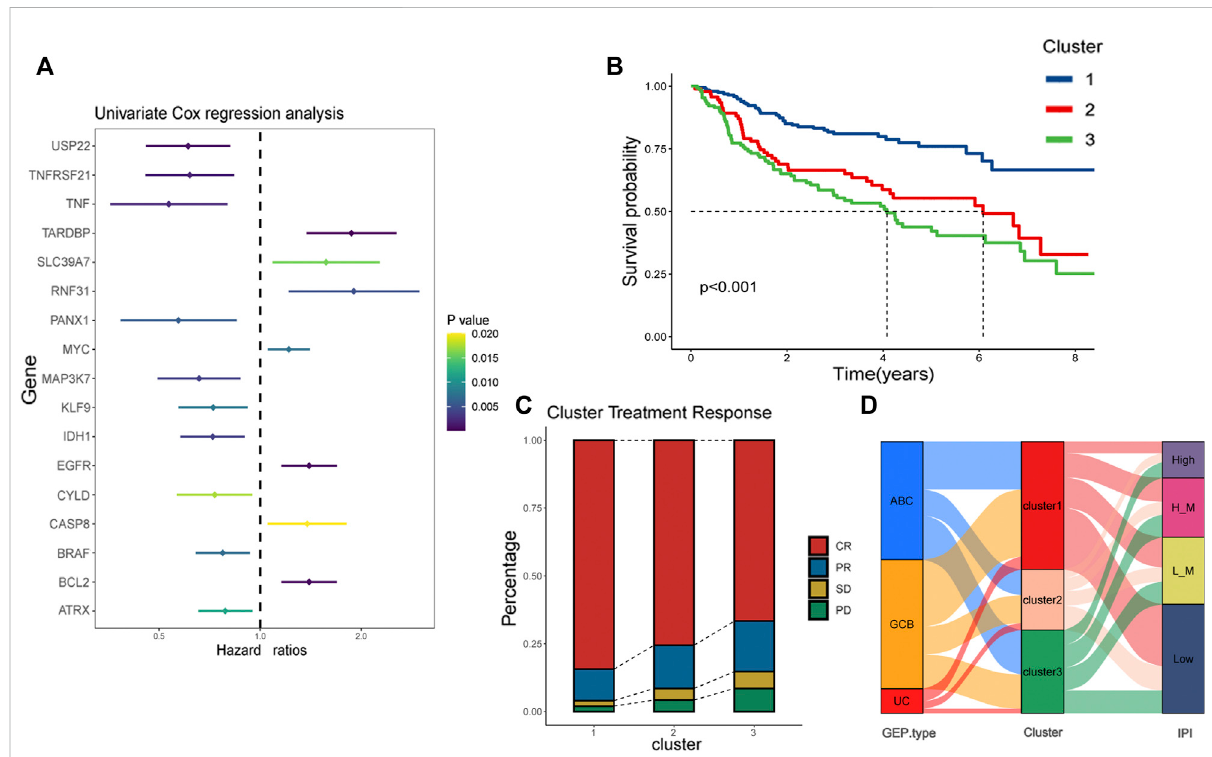
FIGURE 2 Identi fi cation of necroptosis-related clusters and clinical correlation analysis. (A) Risk ratios of 17 DLBCL prognosis-related necroptosis genes. Vertical coordinate is gene name, and horizontal coordinate represents risk ratio. Right side is p -value range symbolizing that the lighter the color, the larger the p -value. (B) Kaplan-Meier plots showing the prognosis of three necroptosis patterns in 421 patients from GSE31312. Blue line represents cluster 1,red cluster 2, and green cluster 3. Cluster 1has thebest prognosis. (C) Response ofpatients in thethree clusters to RCHOP regimen treatment, with the vertical axis as a percentage. Red represents CR, yellow PR, green SD, and pink PD. (D) Alluvial is used to observe the relationship between cluster 1, cluster 2, and cluster 3 with IPI and GEP type. The red part of the middle bar represents cluster 1, pink cluster 2, and green cluster 3. “ L_M ” means low-intemediate, and “ H_M ” means